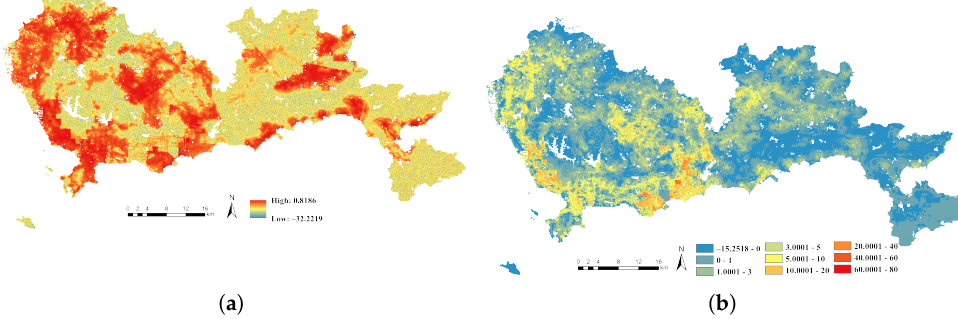
Figure 10. The diffusion coefficient distribution and population growth rate in Shenzhen from 2011 to 2020. ( a ) The diffusion coefficient distribution. ( b ) The distribution of population